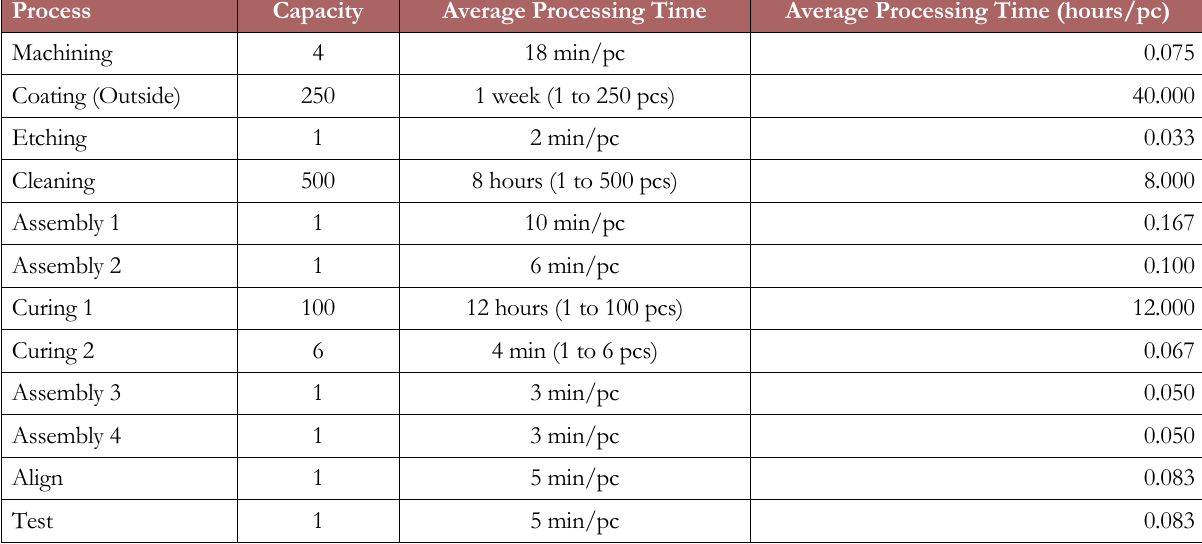
Table 2. Cell Capacities and Processing